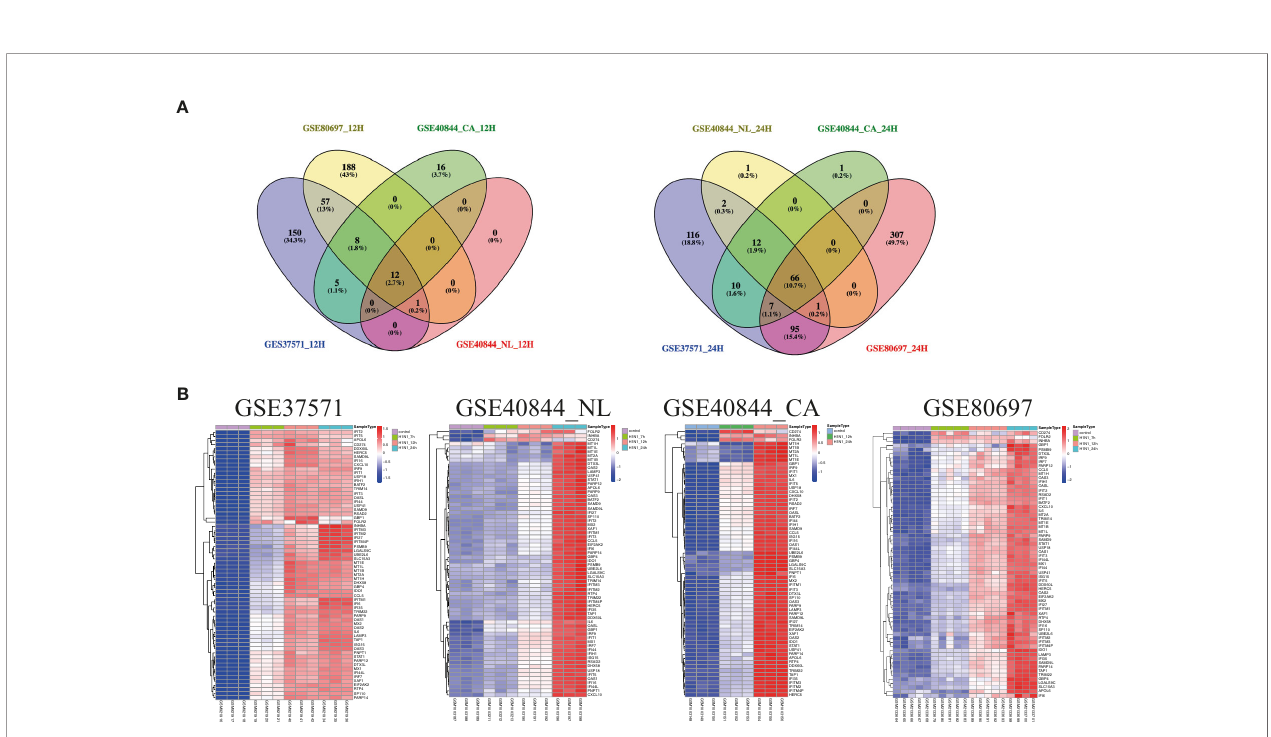
FIGURE 2 | The expression pro fi ling of common genes from four different data series infected with H1N1 in Calu-3 cells. (A) Venn diagram of the overlap genes between different data with 12 hpi (left) or 24 hpi (right). Twelve genes were common to the four H1N1-infected Calu-3 cells at 12 hpi, while 66 overlapped genes were found at 24 hpi. (B) Heatmap of differentially expressed patterns of the overlap genes in IAV-infected Calu-3 cells. Row represents the overlap genes and each column corresponds to a sample. NL: A/Netherland/219/2003, CA: